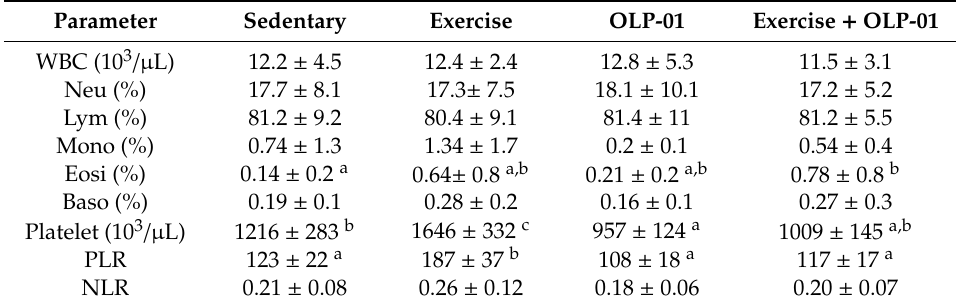
Table 4. E ff ects of exercise and probiotic interventions on complete blood count